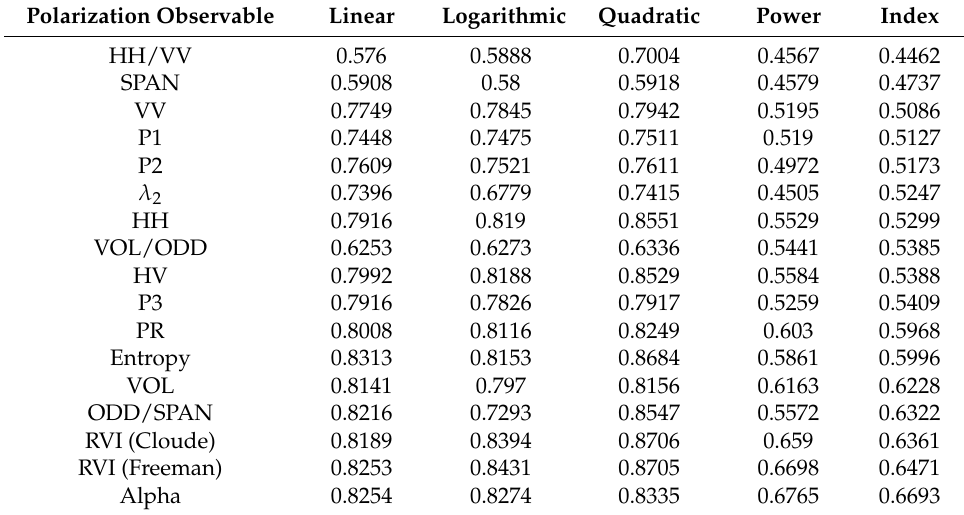
Table 5. Coefficients of determination (r 2 ) of five empirical regression models for Leaf area index (LAI)